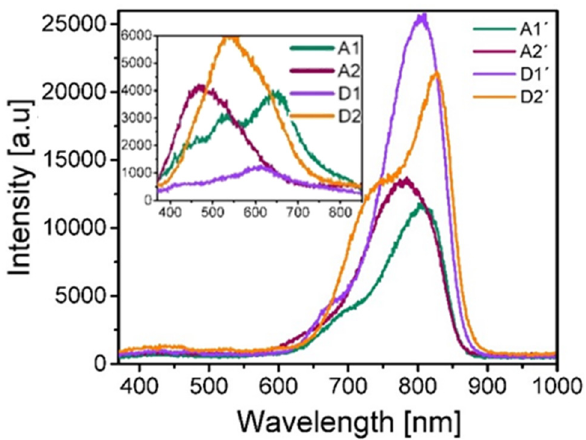
Figure 8. Photoluminescence spectra measured from deposited SiO x films.